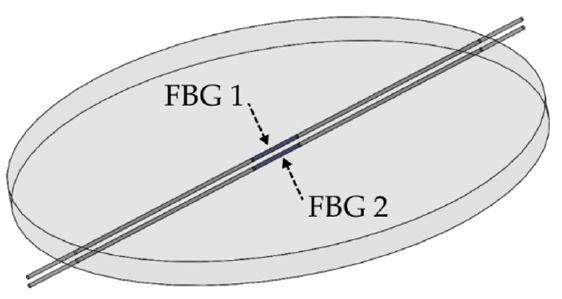
Figure 1. Structure of the silicone rubber diaphragm with two inserted FBGs. For sensor analyses, the sm125 FBG interrogator (Micron Optics, Atlanta, GA, USA) with 1 pm resolution was used to acquire the reflected